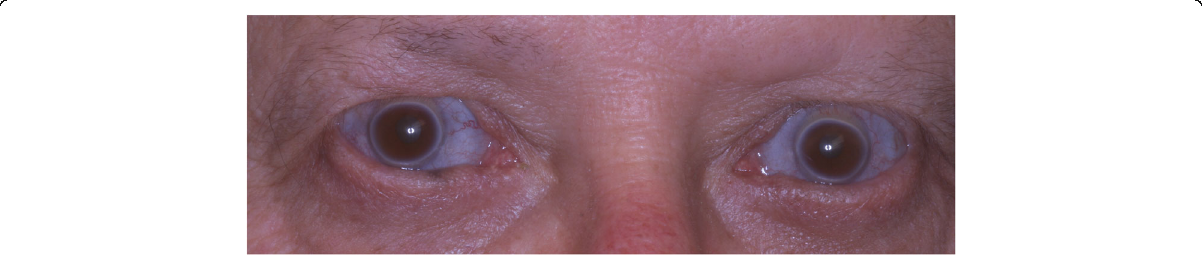
Fig. 1 Characteristic blue